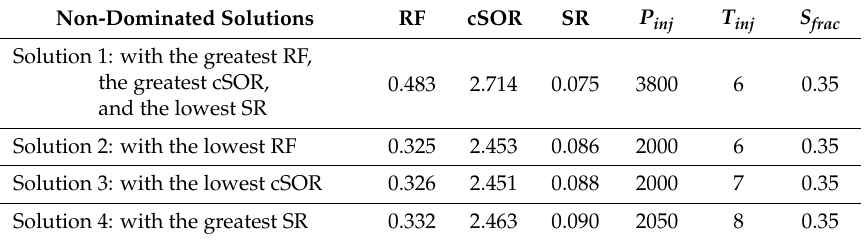
Table 7. Decision variables and performance indicators obtained by running the hybrid multi-objective optimization